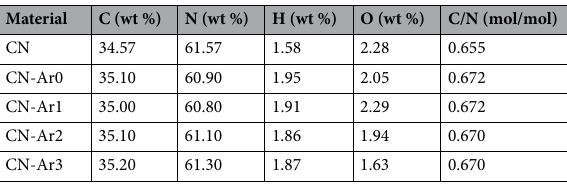
Table 5. Bulk elemental analysis of CN and CN-Ar materials.